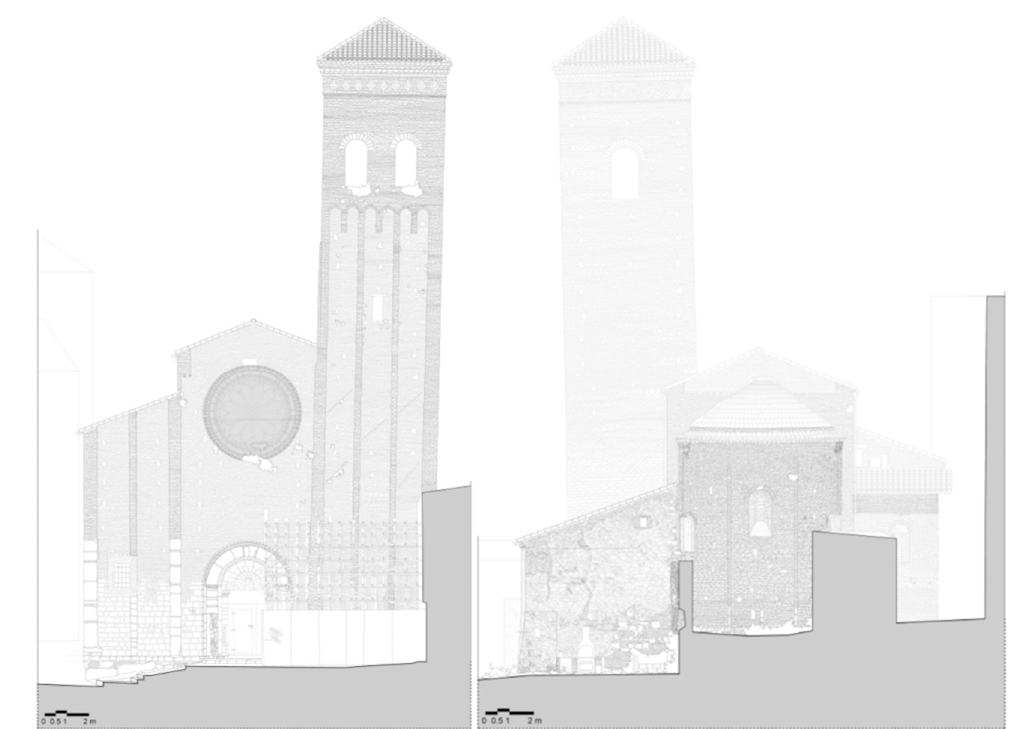
Figure 6. Northern facade and Southern back side of the church (architectural survey).